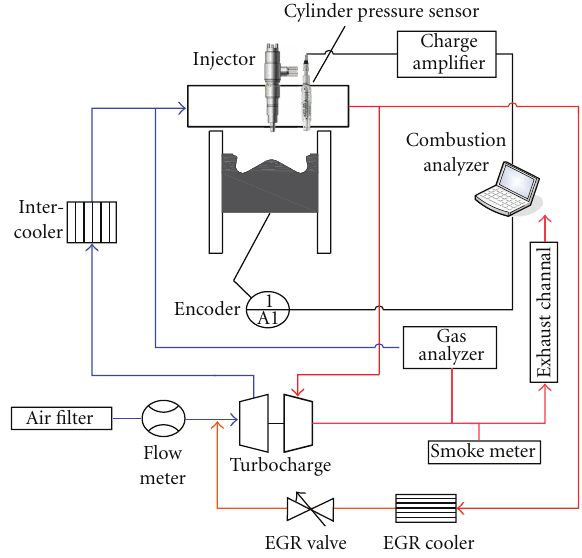
Figure 6: Experimental